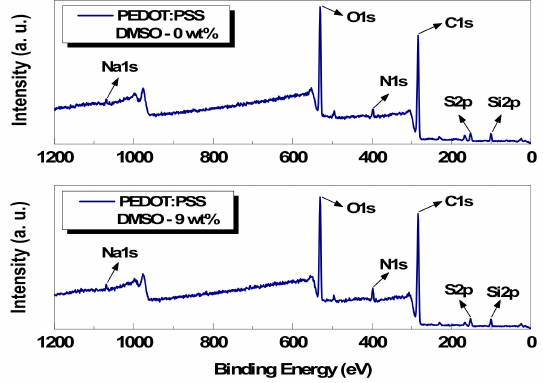
Figure 5. Wide-scan survey spectra of pristine and 9 wt% DMSO paste